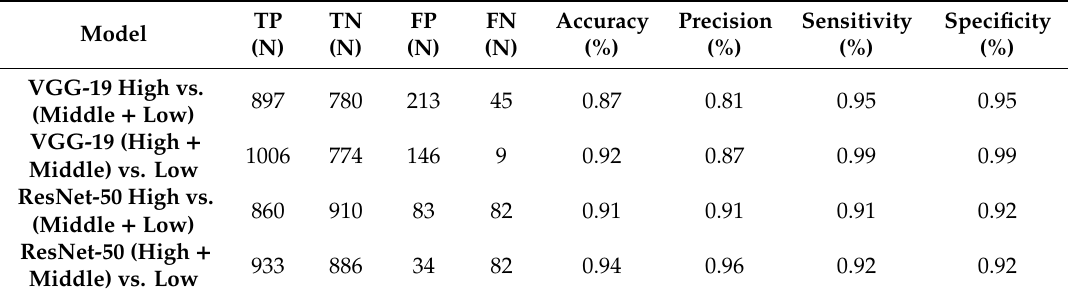
Table 4. The testing results for the VGG-19 and ResNet-50 models. TP, TN, FP, and FN denote the true positive, true negative, false positive and false negative pulses, respectively.